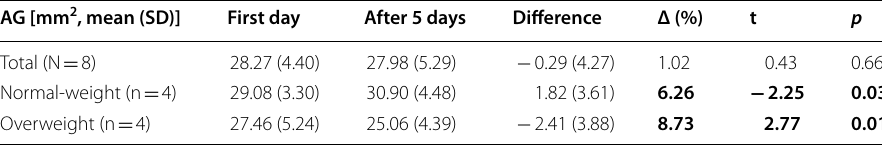
Items in bold: significant t-value AG: air gap; SD: standard deviation; Δ: